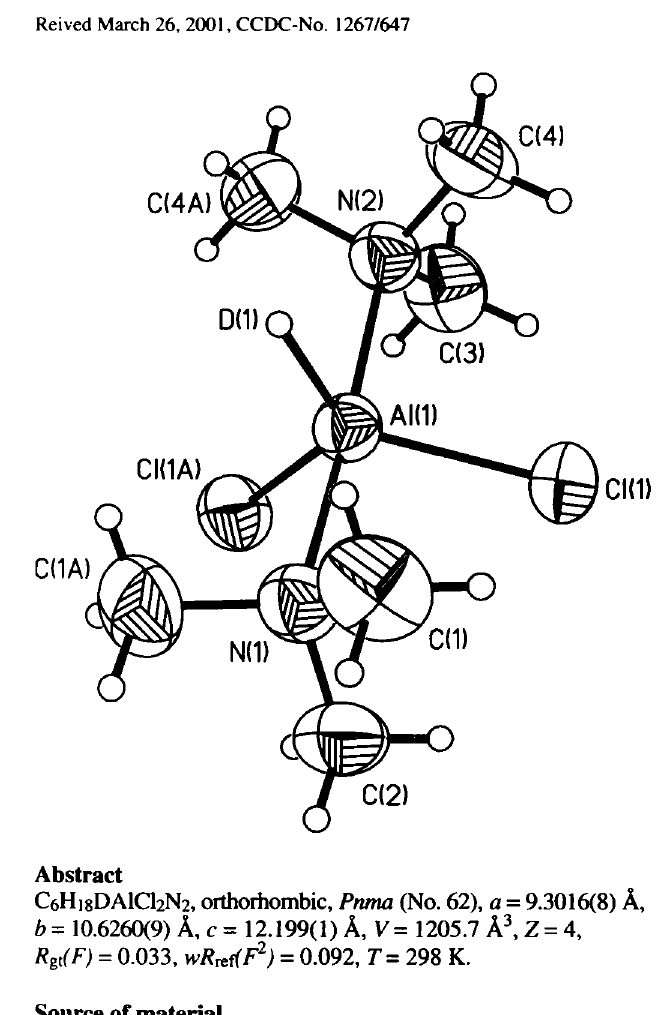
Table 1. Data collection and